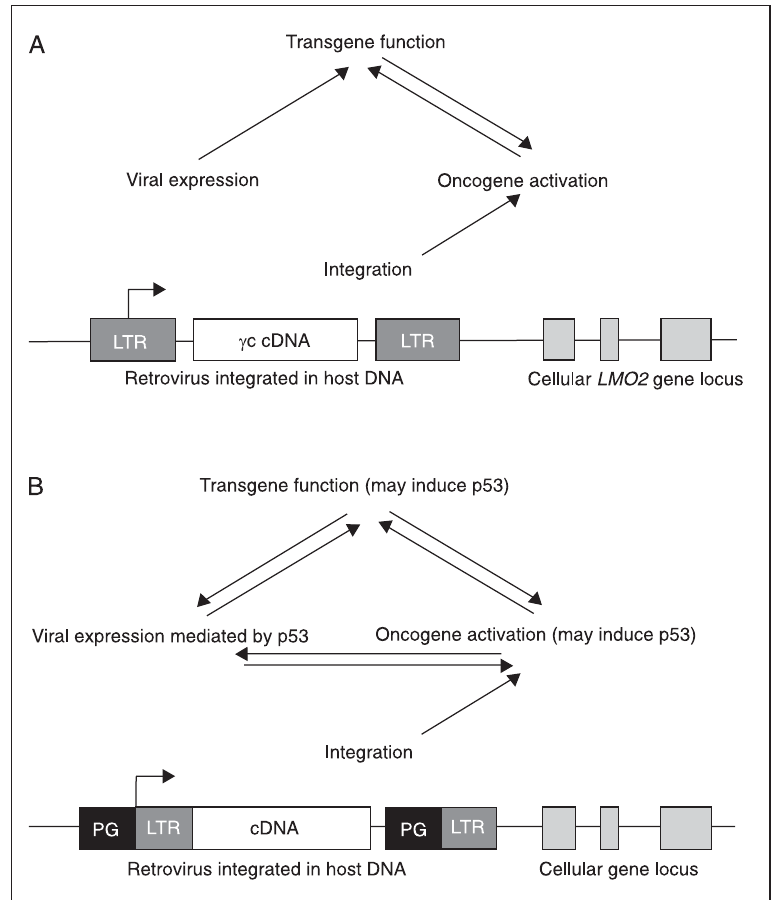
Figure 1. Overview of the influence of the virus on cellular and therapeutic gene